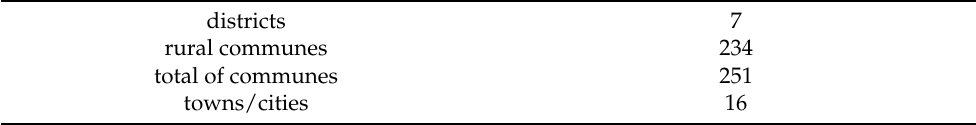
Table 4. Administrative division of West Slovakia (Trnava region). districts 7 rural communes 234 total of communes 251 towns/cities